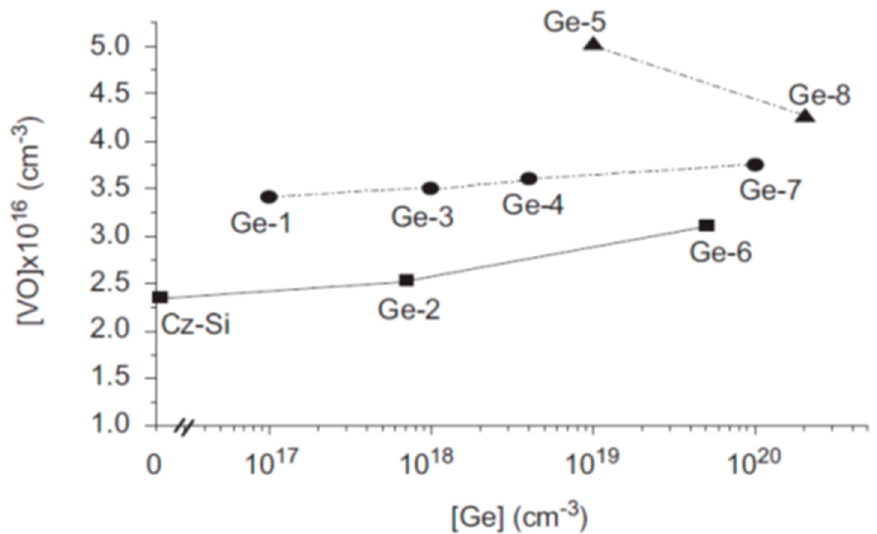
Figure 5. The production of the VO defect as a function of the Ge dopant concentration in the Si samples. Reproduced with permission from [37]. Elsevier, 2009. Table 3. The concentrations of Ge, O i and C s of the Cz–Si:Ge samples used in Figure 5 [37,127].